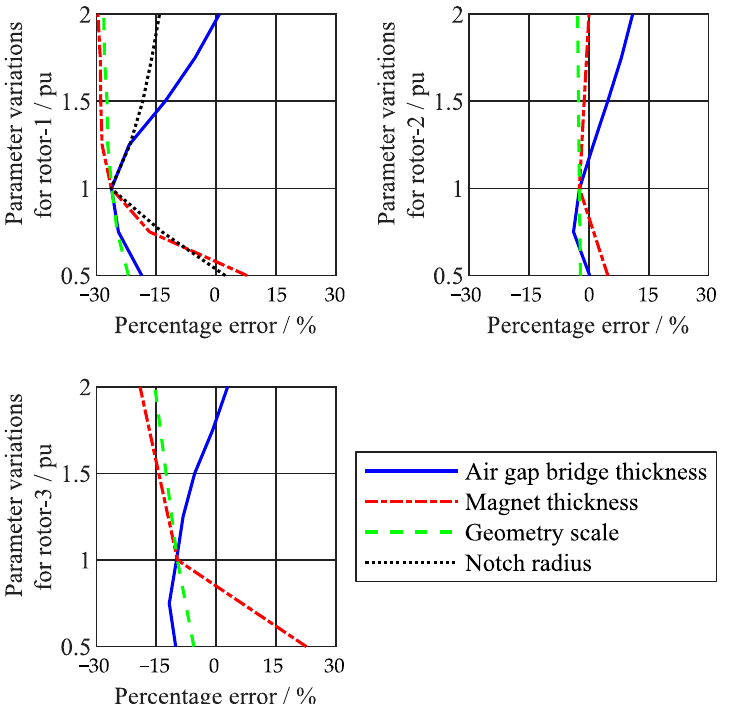
Figure 11. Stability analysis of the ERM5 method for parameter variations of various rotor geome- tries.